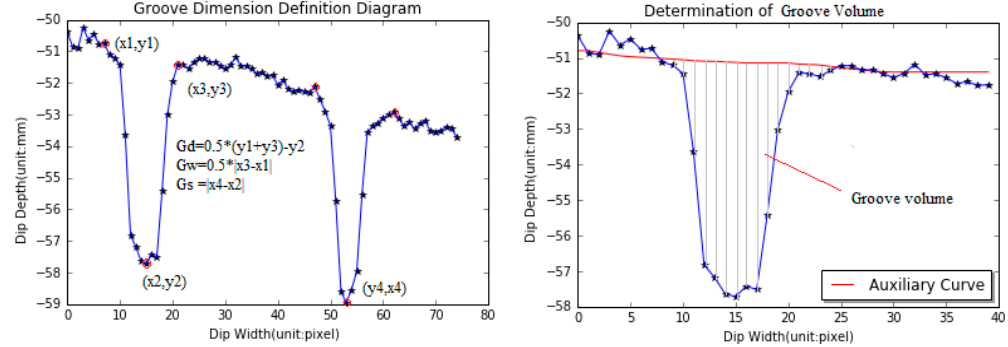
Figure 7. Diagram of calculation of a dip dimension.